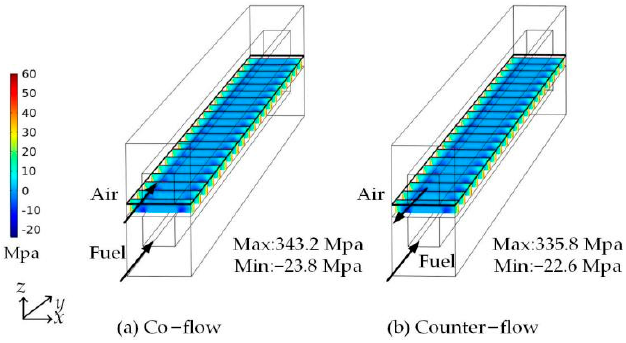
Figure 13. Distribution of temperature for case C.